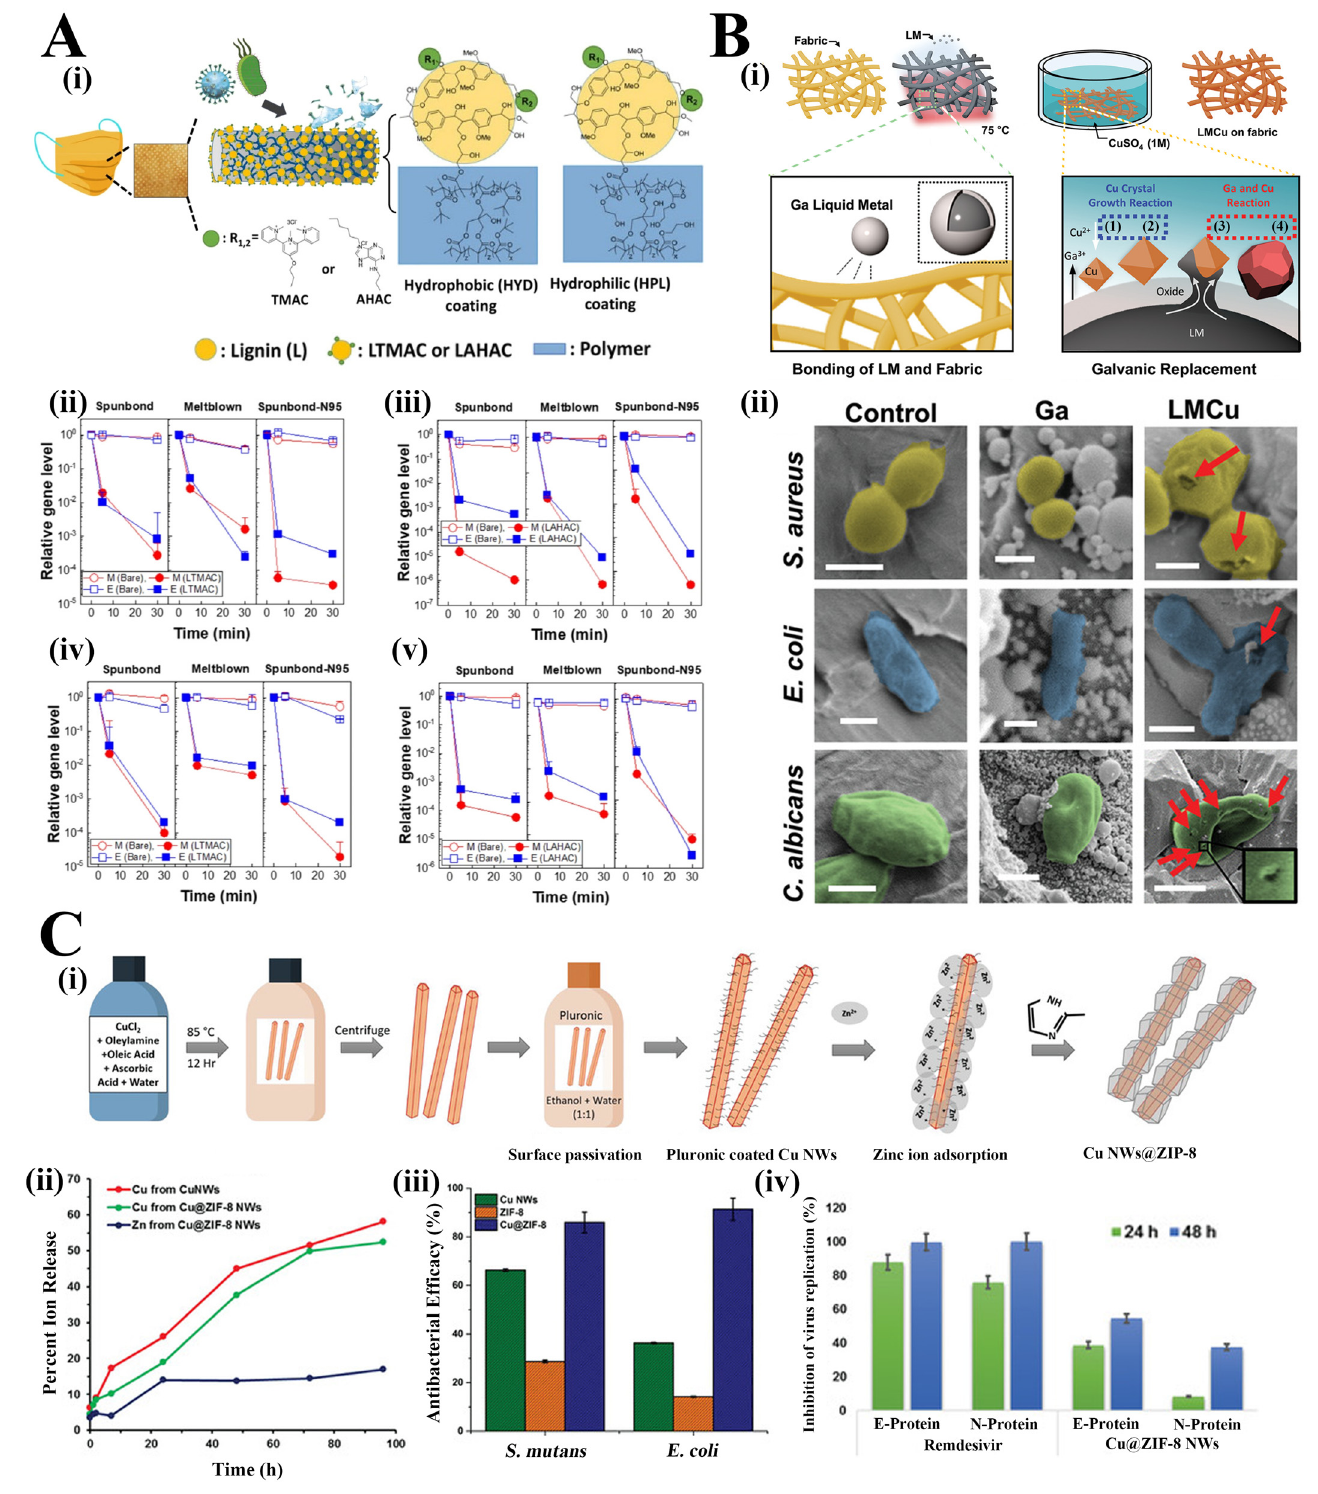
Figure 1. ( Ai ). Schematic illustration of the UV cross-linked coating on the surface of the face mask. Gene expression level change of HCoV-229E ( Aii , Aiii ) and HCoV-OC43 ( Aiv , Av ) on lignin-based, LTMAC- ( Aii , Aiv ) and LAHAC- ( Aiii , Av ) coated face mask fabrics (spunbond: outer layer of SM, meltblown: middle layer of SM and spunbond-N95: outer layer of N95) (n = 3, mean ± SD) [92]. ( Bi ). Schematic illustration of the gallium-copper (LMCu) coatings on fabric by galvanic replacement. ( Bii ). False coloured SEM images of S. aureus, E. coli and C. albicans cells on the control, Ga coated, and LMCu coated fabric (scale bars: 500 nm for S. aureus and E. coli and 2 µm for C. albicans ): red